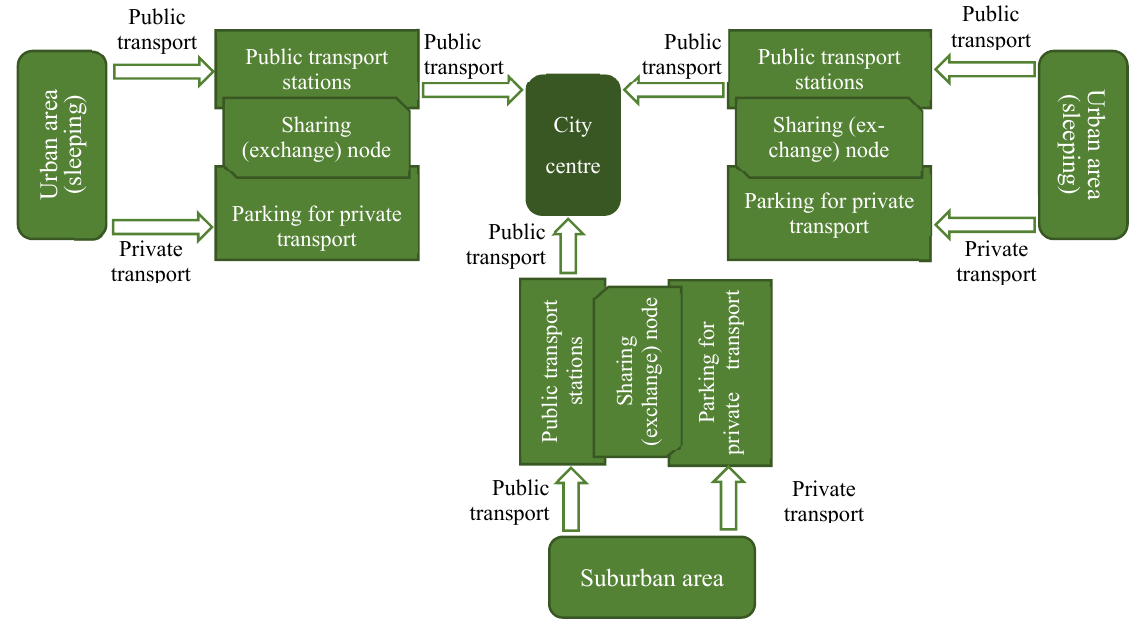
Figure 1. Making journeys using “Park and ride” (based on [24]).